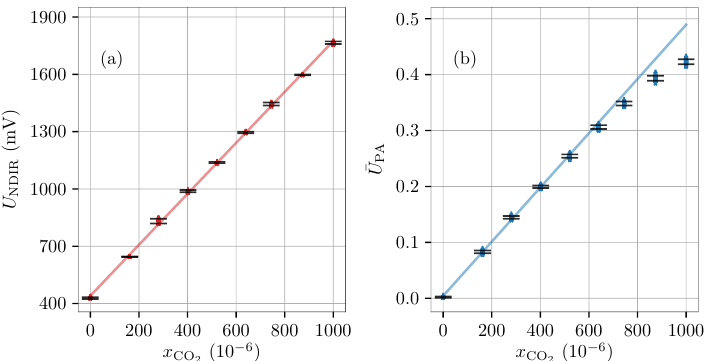
Figure 2. Calibration of carbon-dioxide sensor response in dry nitrogen gas samples. ( a ) NDIR sensor response, and ( b ) power-normalized QEPAS sensor response. The error bars ( y -direction) identify the 1 σ variation of datapoints around the mean value of each dataset. During the calibration procedure, the pressure and temperature were P = ( 1012 1 ) hPa and T = ( 22.8 0.1 ) ◦ C, ± ±